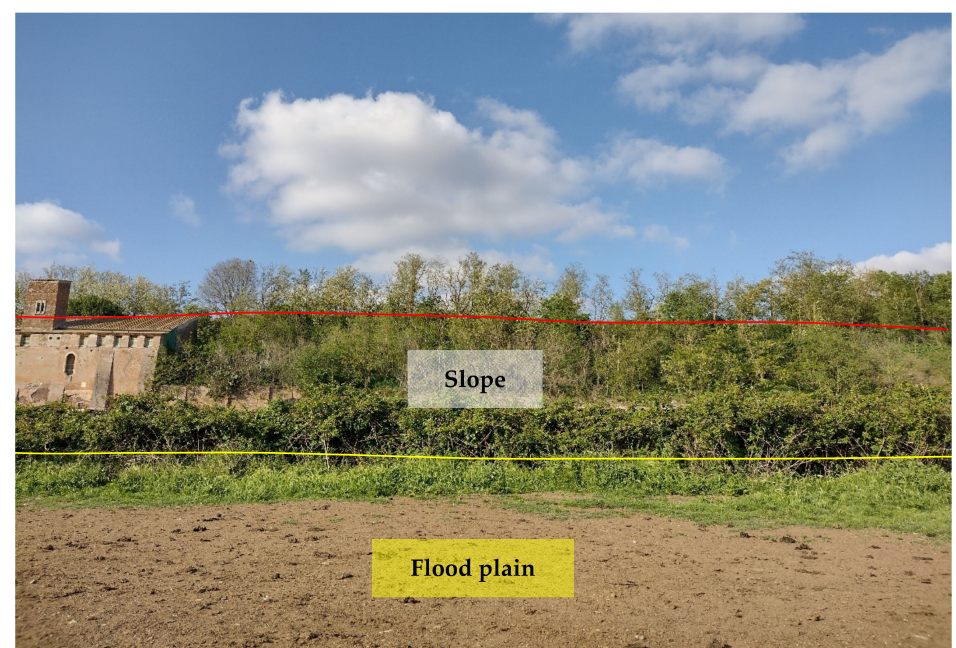
Figure 5. Flat surface on east side of the Caffarella valley. Flood plain is at about 20 m a.s.l., top of the structural landform (red line) is at about 43 m a.s.l. Yellow line: base of the slope (45–80 ◦